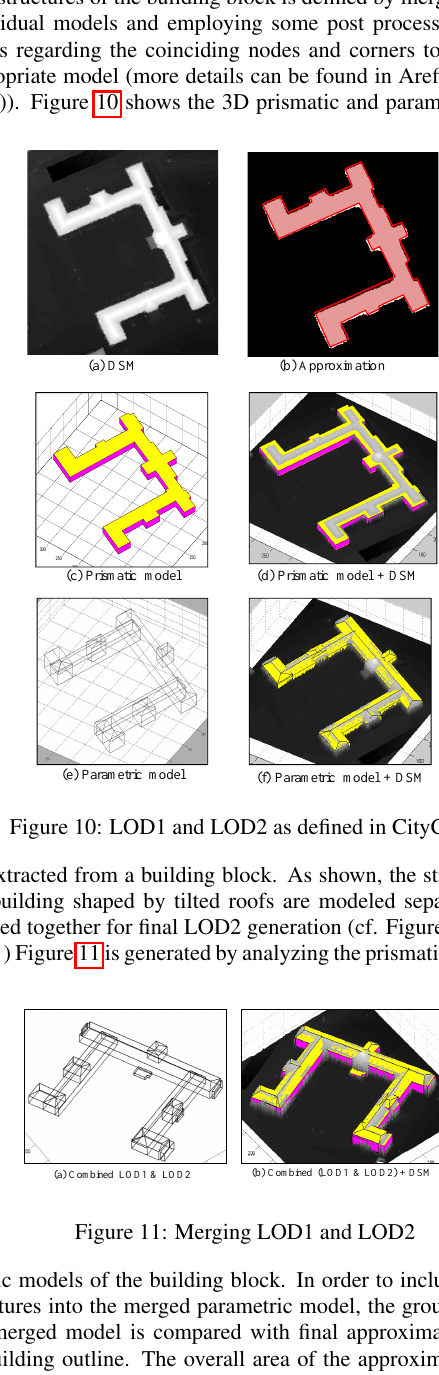
responding roof types cannot be distinguished by the proposed algorithm, a prismatic model is fitted to the points.